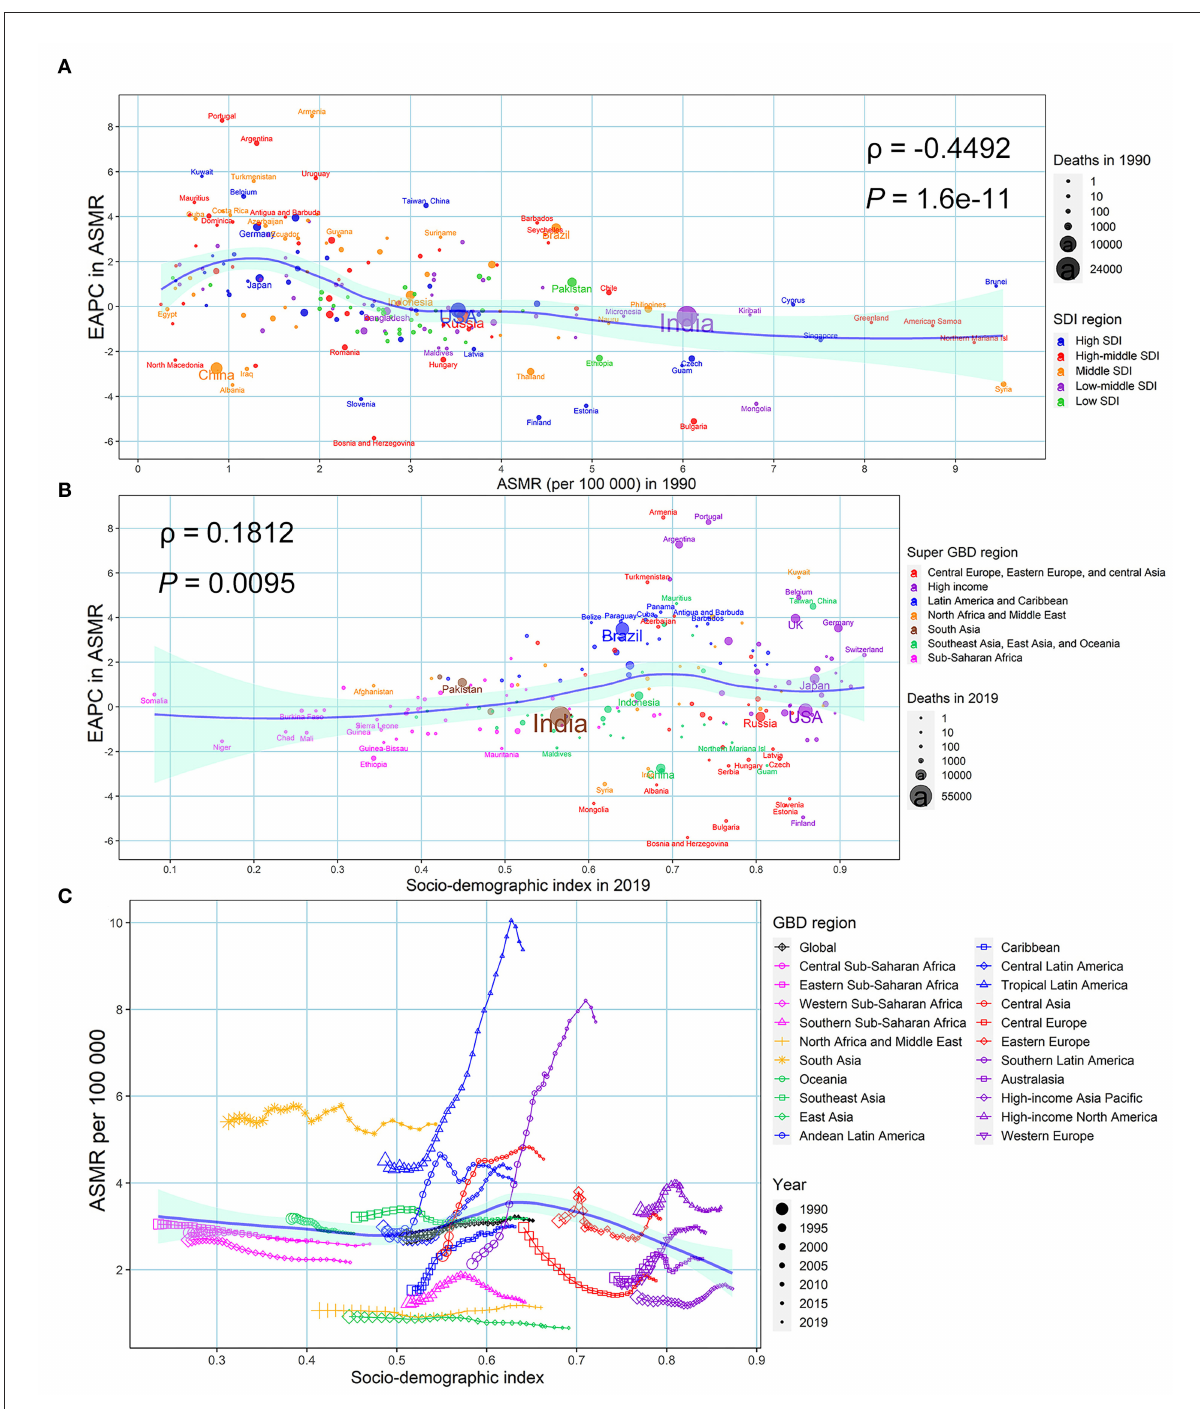
FIGURE5 Factors associated with EAPC in ASMR associated with urinary tract infection in both sexes from 1990 to 2019. (A) ASMR associated with urinary tract infection in 1990 at the national and territorial level (baseline burden). (B) SDI associated with urinary tract infection in 2019 at the national and territorial level (development status). (C) Annual changing trajectory in ASMR of urinary tract infection across 21 GBD regions according to corresponding annual SDI. The blue line was fitted by LOESS. ASMR, age-standardized mortality rate; EAPC, estimated annual percentage change; SDI, socio-demographic